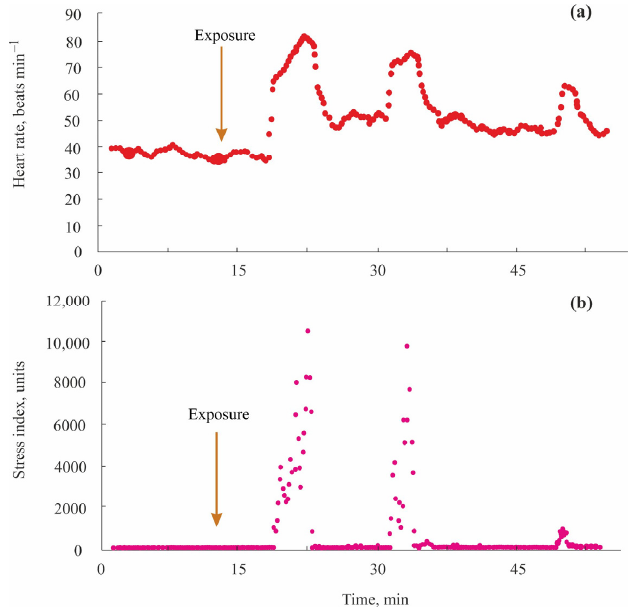
Figure 9. Heart rate ( a ) and stress index ( b ) in narrow-clawed crayfish Pontastacus leptodactylus exposed to hydroquinone (1 g L − 1 ) (adopted from [76]).